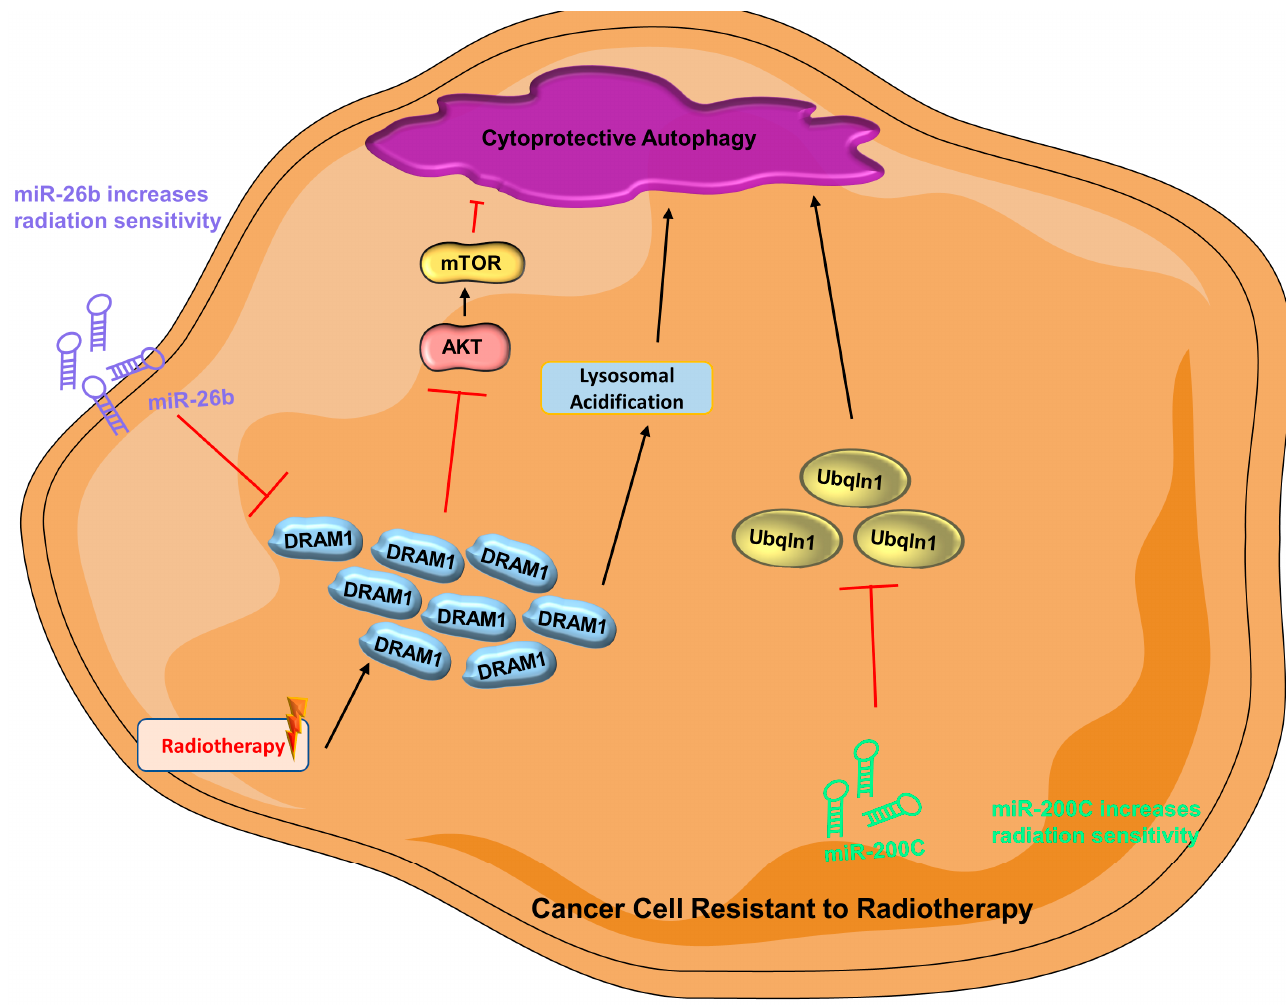
Figure 3. Cytoprotective autophagy is activated in cancer cells resistant to radiotherapy (AKT = protein kinase B; DRAM1 = damaged-regulated autophagy modulator 1; miR-200C = microRNA 200c; miR-26b = microRNA 26b; mTOR = mammalian target of rapamycin; PI3K = phosphoinositide 3-kinase; Ubqln1 = Ubiquilin-1).